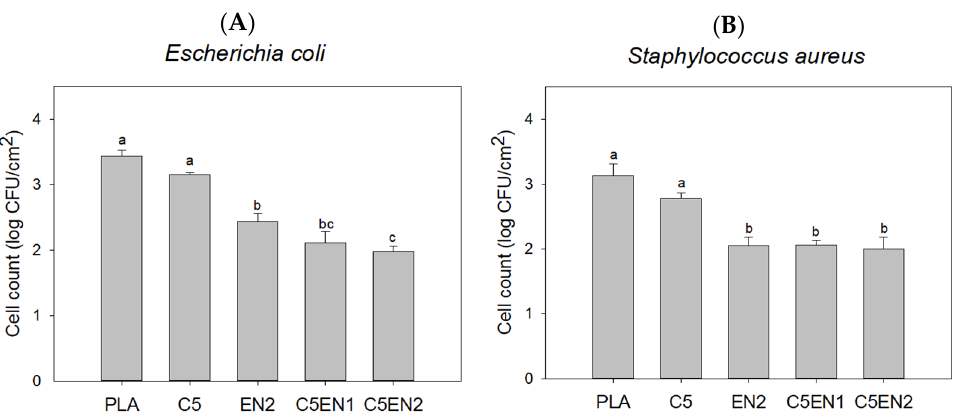
Figure 3. Antibacterial activity of chitosan, EDTA and nisin composite PLA films against Escherichia coli BCRC11634 ( A ) and Staphylococcus aureus BCRC10451 ( B ). PLA, PLA film as control; C5, PLA+0.5% chitosan; EN2, PLA + 20 mM EDTA + 0.02% nisin; C5EN1, PLA + 0.5% chitosan + 20 mM EDTA + 0.01% nisin; C5EN2, PLA + 0.5% chitosan +20 mM EDTA + 0.02% nisin. Data are presented as mean ± SD (n = 3). Different letters were significant difference ( p <